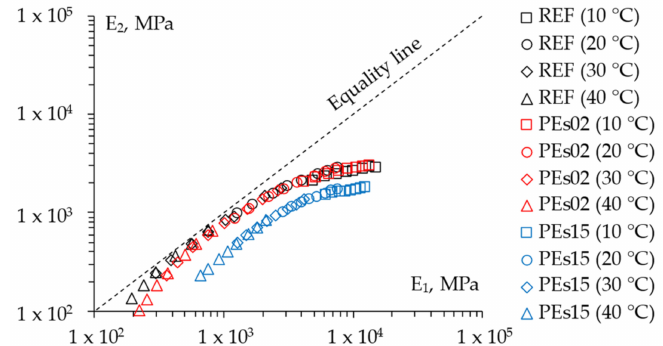
Figure 7. The 4PB experimental findings: Cole–Cole